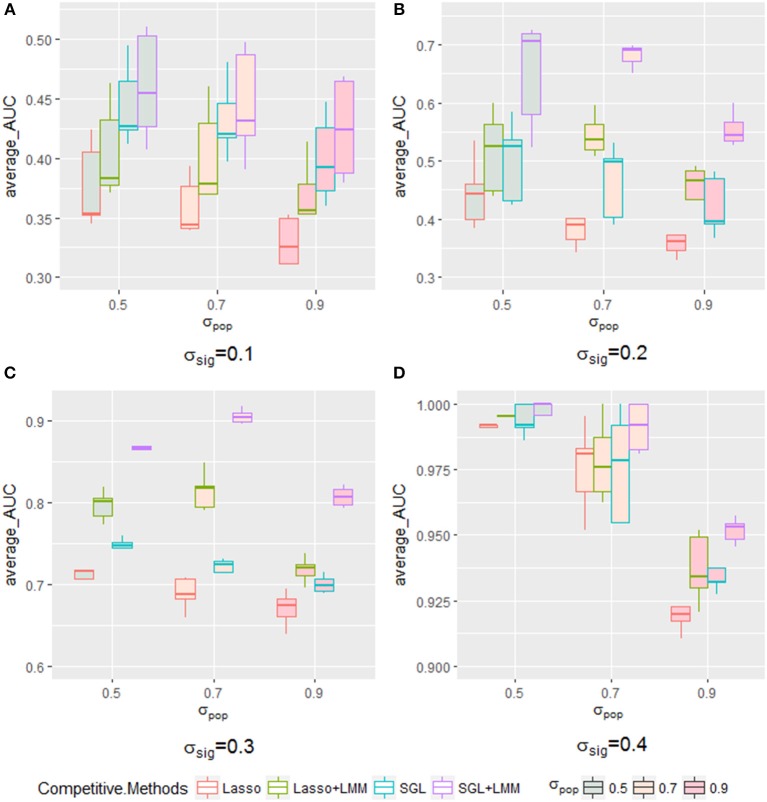
The boxplot of a sample of five points for each method with a specific σsig when varying the σpop. Each method with a different color frame and each σsig filled with a different color are shown in the legend. (A) for σsig = 0.1, (B) for σsig = 0.2, (C) for σsig = 0.3, and (D) σsig = 0.4.